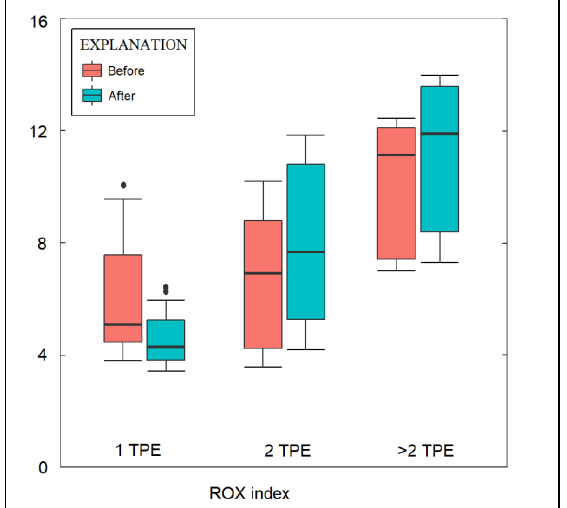
Figure 1. The influence of TPE on the ROX index by number of TPE sessions.